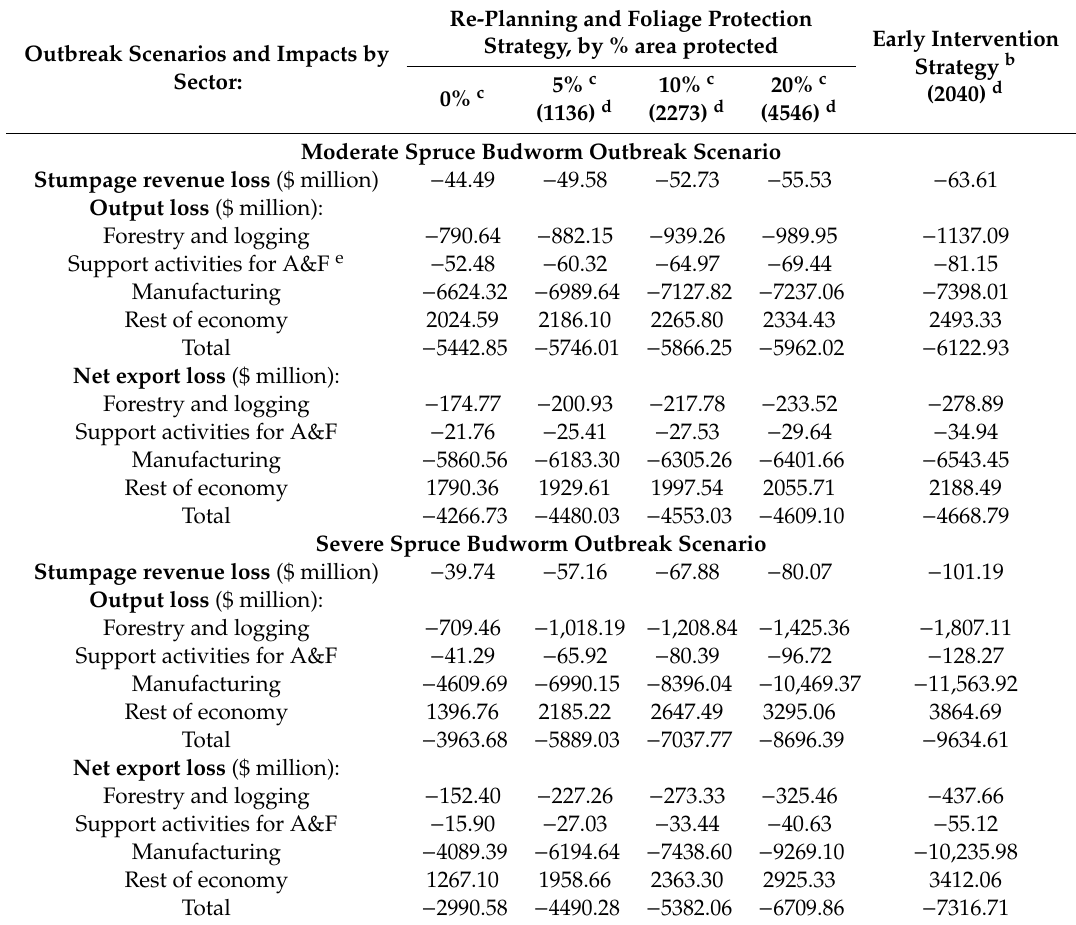
Table 3. Present value a cumulative (2010–2060) stumpage revenue, output ($ million CAD) and net export ($ billion CAD) impacts, by sector, of spruce budworm outbreak and protection scenarios on Crown Land in New